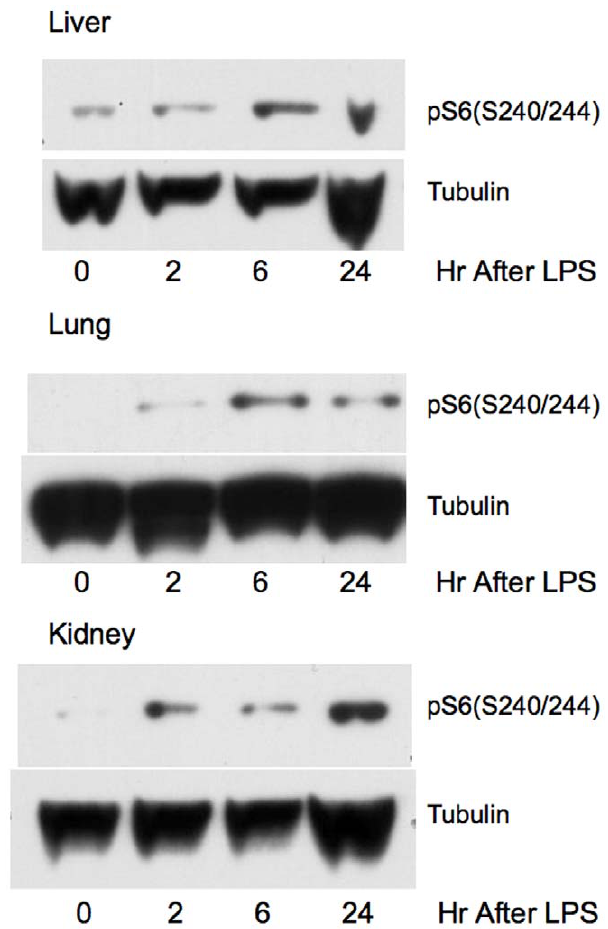
Figure 5. mTORC1-S6K activation in endotoxemic TNFR-null mice. Transgenic mice deficient in TNF- a receptors (TNFR) were given LPS and sacrificed at 2, 6, and 24 hr later for organ extraction. Representative immunoblots probed for pS6 (S240/244), a downstream target of mTORC1-S6K are shown here. mTORC1-S6K activation could be observed in the livers, lungs and kidneys of these mice similar to wildtype mice.